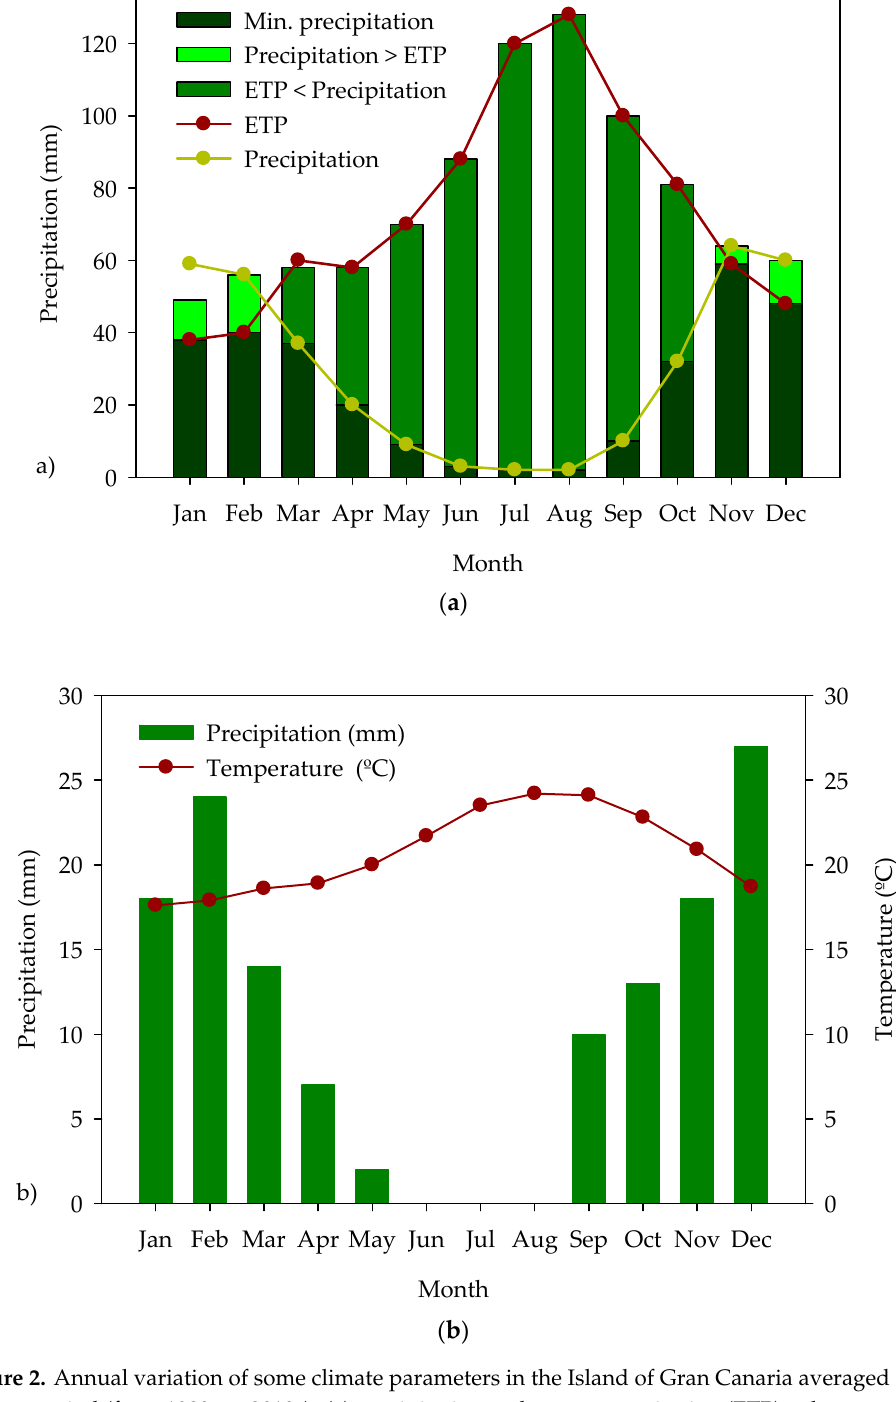
Figure 2. Annual variation of some climate parameters in the Island of Gran Canaria averaged over a 30 year period (from 1980s to 2010s): ( a ) precipitation and evapotranspiration (ETP) values, as well as the minimum (min) effective precipitation values and the time intervals during which ETP exceeded rainfall and vice versa; ( b ) rainfall and temperature.